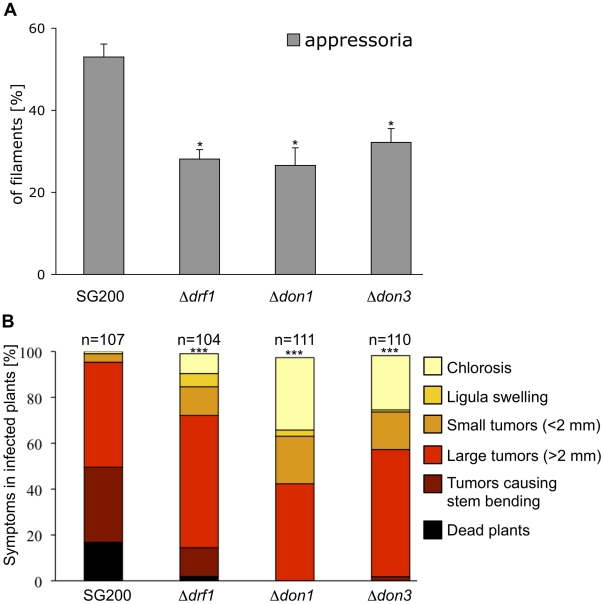
Appressoria formation and virulence are reduced in the drf1, don1 and don3 deletion strains.A: The indicated strains were injected into maize seedlings. One day after infection appressoria were quantified on the leaf surfaces using the appressorium specific marker AM1 (n>200). *: p<0.05, when compared to the SG200AM1 strain. The experiment was conducted in three biological replicates. Error bars indicate standard deviations. B: Disease symptoms caused by the solopathogenic SG200AM1 strain and its derivative drf1, don1 and don3 deletion strains (indicated below each column) were scored 12 days after infection. Symptoms were grouped into colour-coded categories according to Kämper et al. [9] depicted on the right. Average values of three independent experiments were expressed as percentage of the total number (n) of infected plants. ***: p<0.0001 using the Wilcoxon ranked sum test, when compared to the SG200AM1 strain.